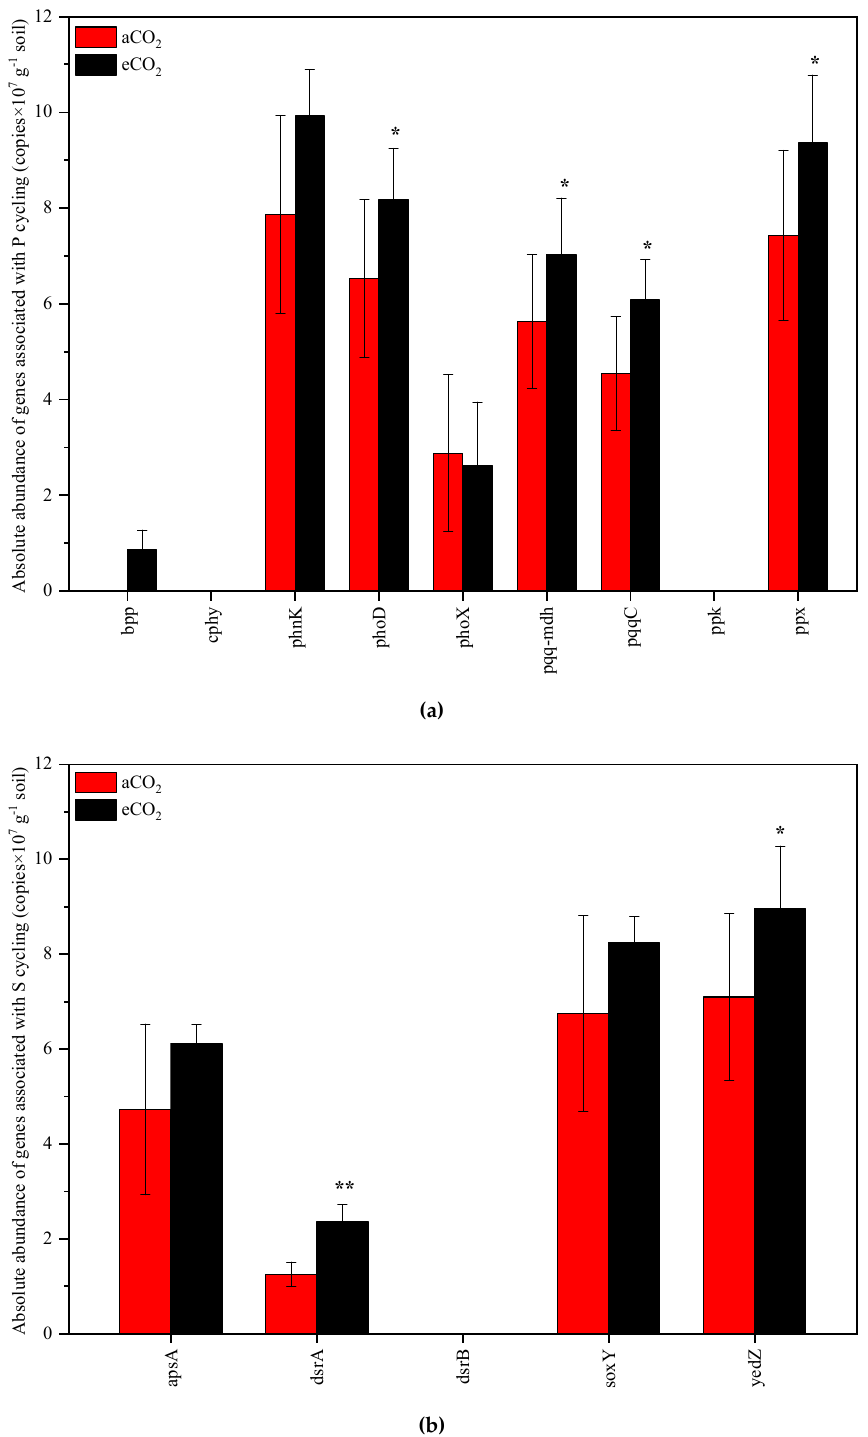
Figure 6. ( a ) Absolute abundance of genes associated with P cycling under aCO 2 and eCO 2 . ( b ) Absolute abundance of genes associated with S cycling under aCO 2 and eCO 2 . p < 0.05, *; p < 0.01, **.